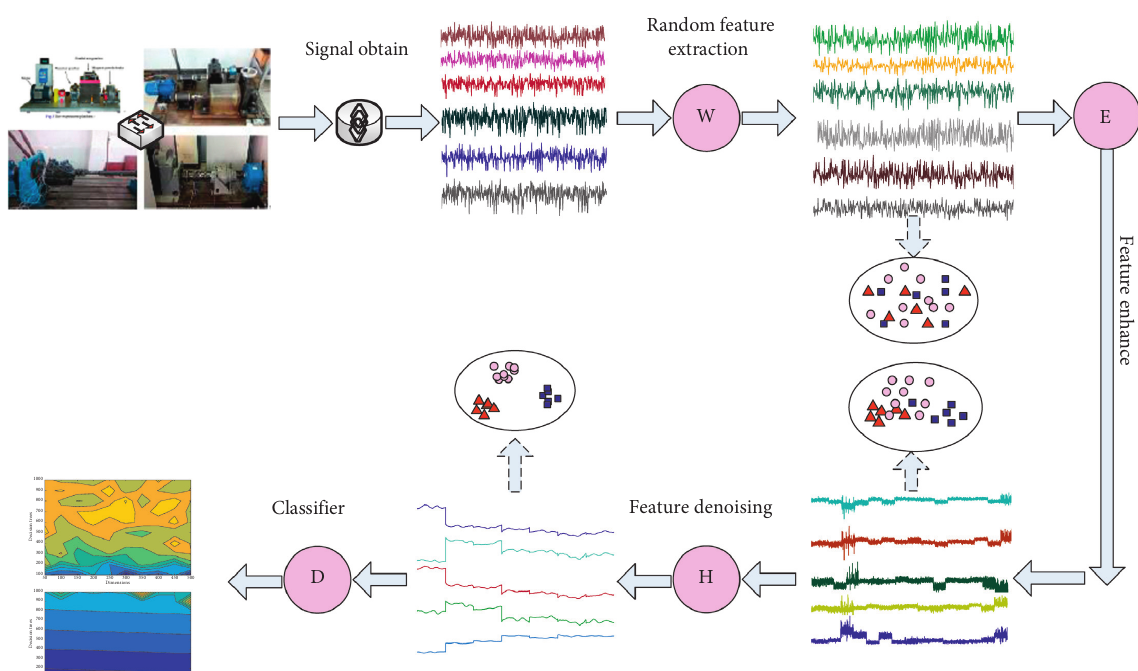
Figure 2: Overview of the proposed SL